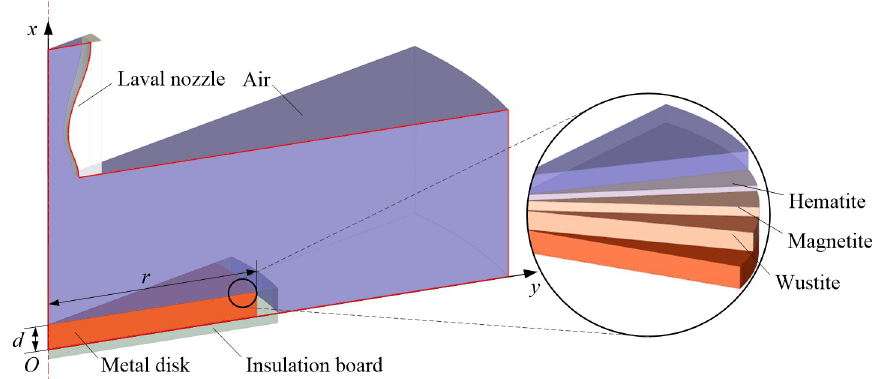
Fig 1. Schematic diagram of the geometry of the forced air quenching of a metal disk.